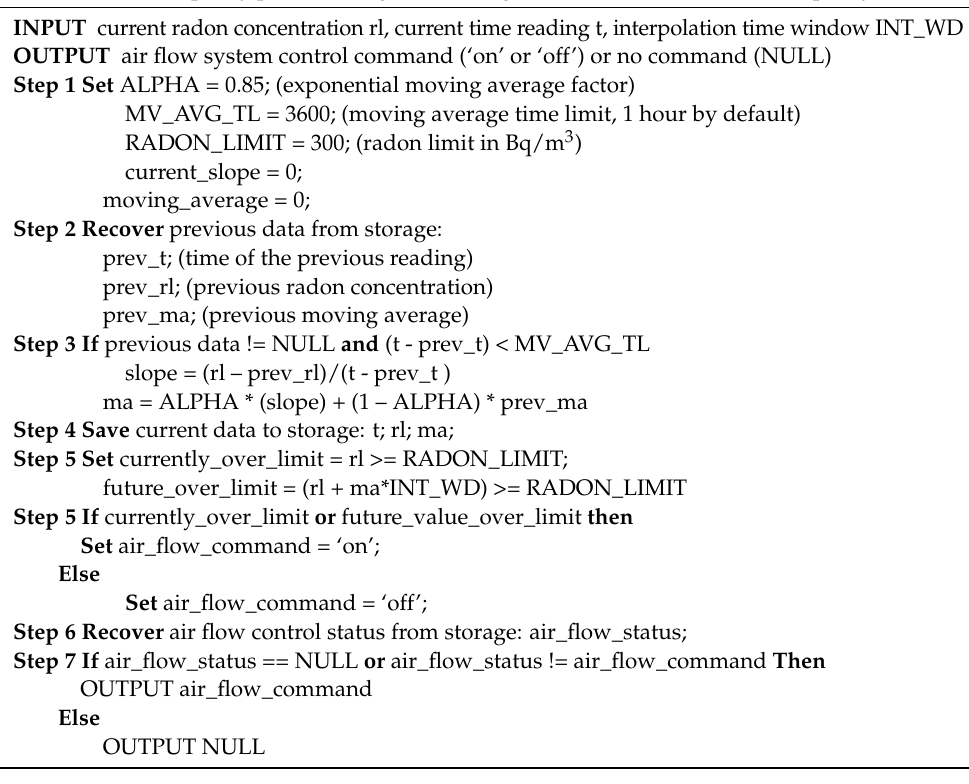
Algorithm 1: Air quality prediction algorithm using radon concentration as the air quality